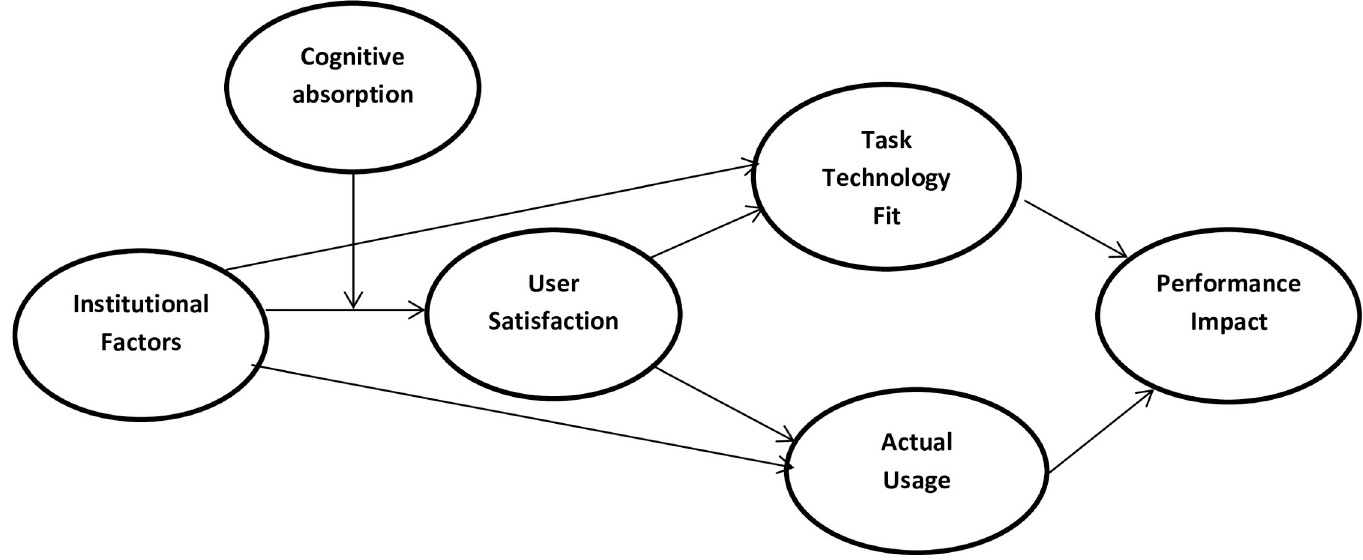
Fig 1. The theoretical framework for the current